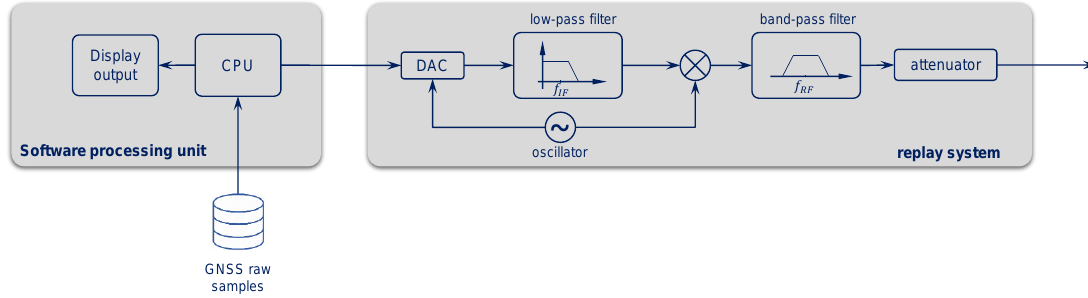
Figure 5. Software processing unit and GNSS replay system. DAC digital-to-analog